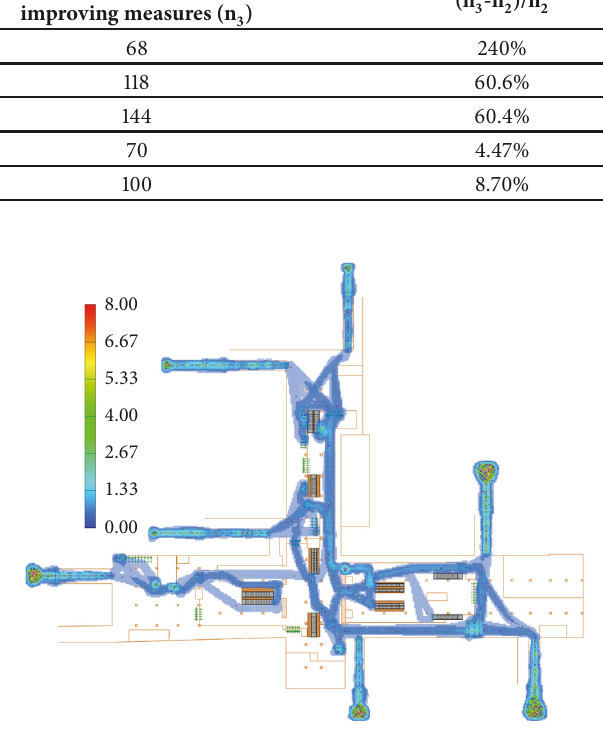
Table 6: Number of passengers entering each gate in 5 minutes with improving measures. Gate No.